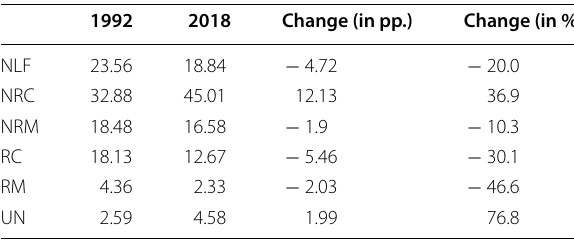
Table 1 Shares by Labor Market State, 1992 and